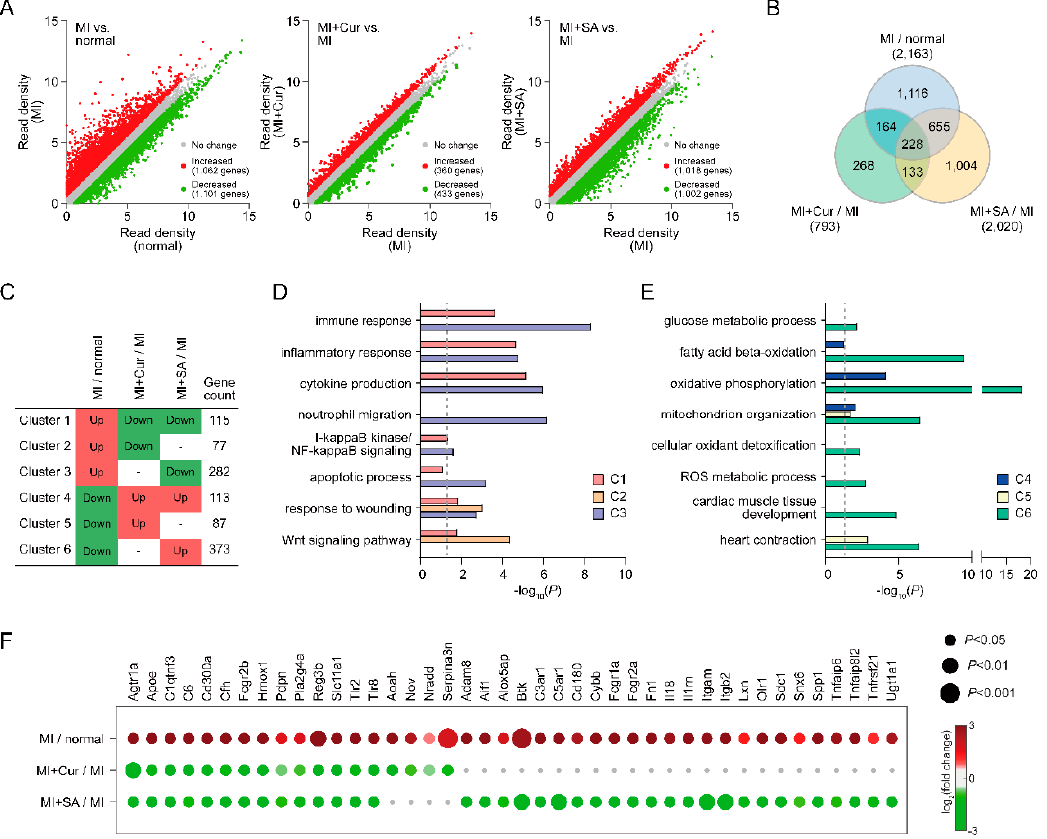
Figure 4. Cellular processes affected by sappanone A. ( A ) Scatter plots of three comparisons (MI versus normal, MI + Curcumin versus MI, and MI + Sappanone A versus MI). ( B ) Relationships among differentially expressed genes (DEGs). ( C ) Clusters (C1-6) of the genes affected by curcumin or sappanone A. Red and green denote up- and down-regulation, respectively. The number of DEGs in each cluster is denoted. ( D , E ) Cellular processes represented by DEGs in C1-6. X-axis, − log 10 (P) where P is the enrichment P-value calculated in DAVID software. ( F ) DEGs involved in inflammatory responses.